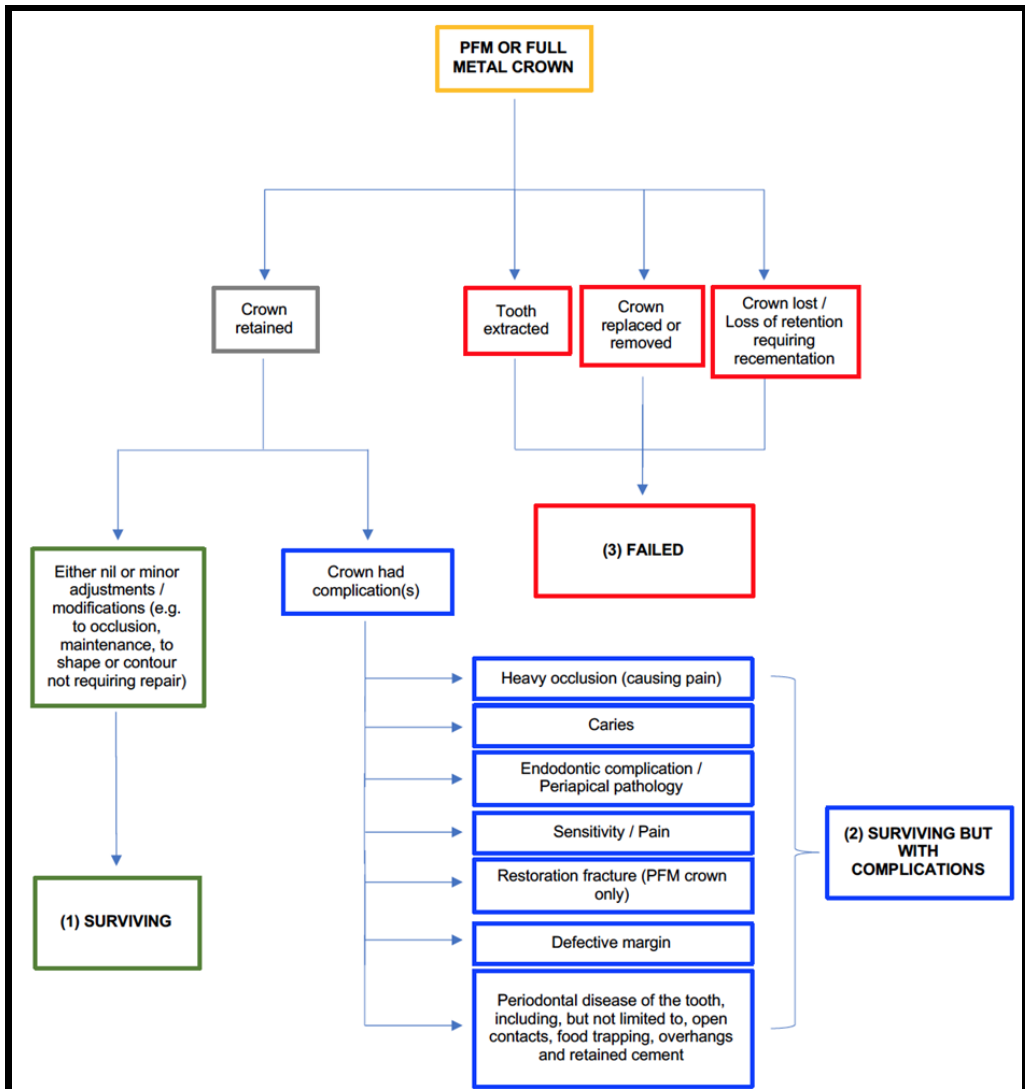
Figure 1. Classification flow chart.